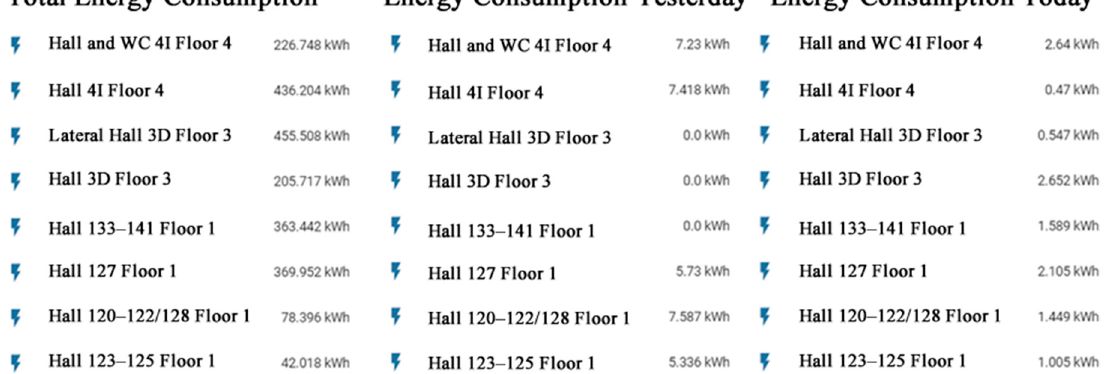
Figure 14. Demand profiles presented by the home assistant.